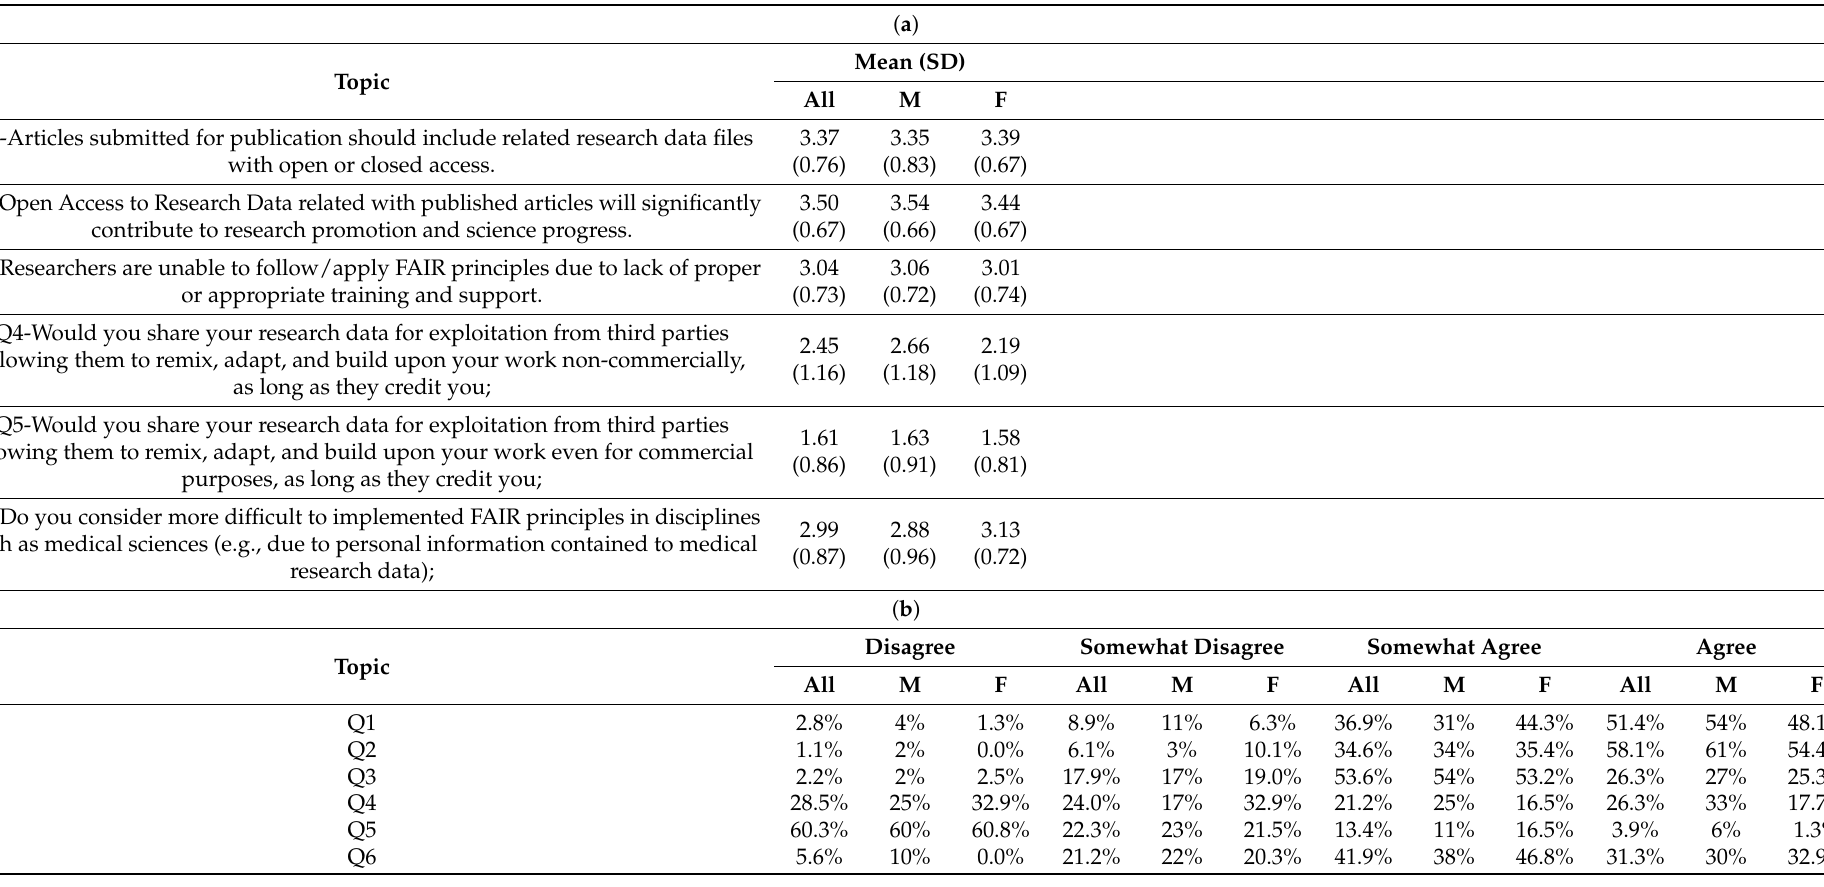
Table 3. ( a ) Define the level of agreement with the following topics regarding Open Research Data-Mean and Standard Deviation per topic (Part 2, Q1 to Q6, All–Male–Female); ( b ) Define the level of agreement with the following topics regarding Open Research Data-Percentages per topic (Part 2, Q1 to Q6,